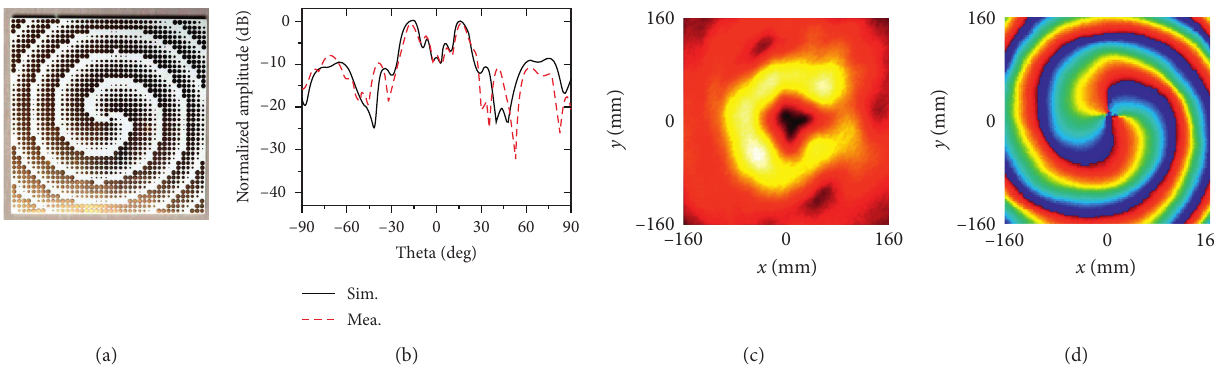
Figure 6: (a) Photograph of the fabricated metasurface. (b) Measured far-field 2D radiation pattern of the E plane. (c) Measured distribution of the transmission amplitude. (d) Measured distribution of the transmission phase at